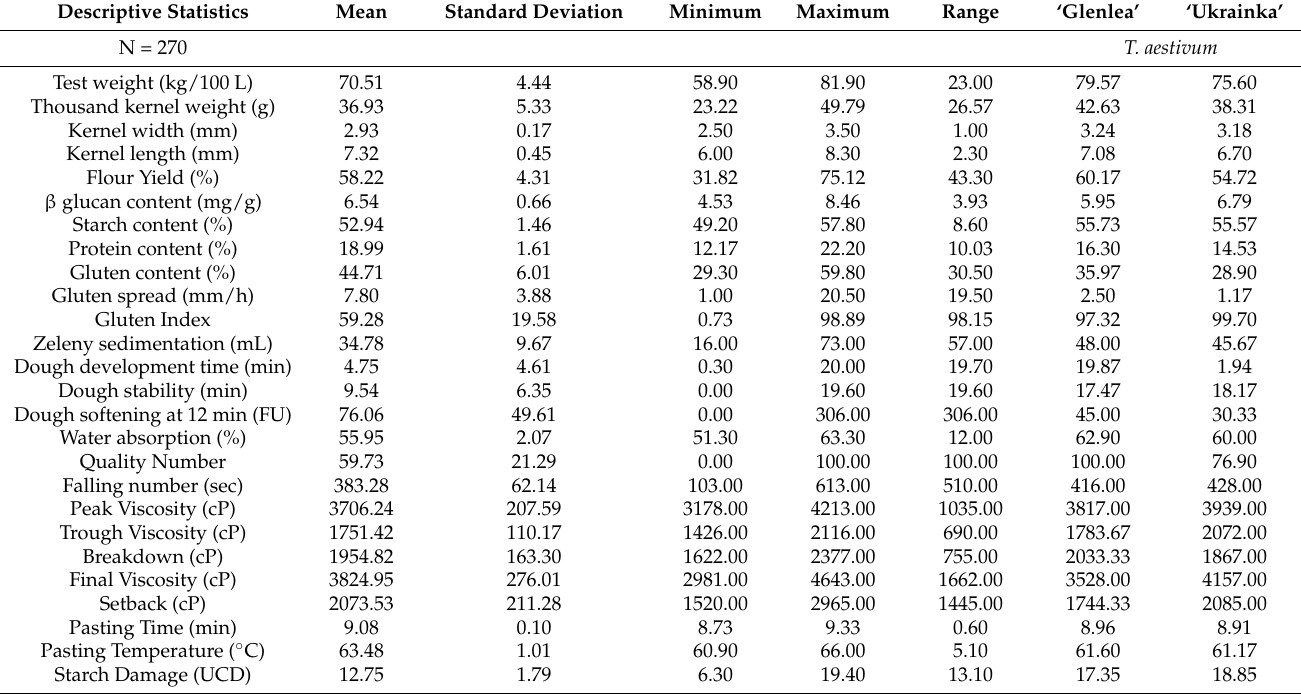
Table 1. Mean, standard deviation, and ranges of physical, compositional, and breadmaking quality traits of 90 Triticum aestivum subsp. spelta genotypes grown in 3 years in Hungary (Martonv á s á r,